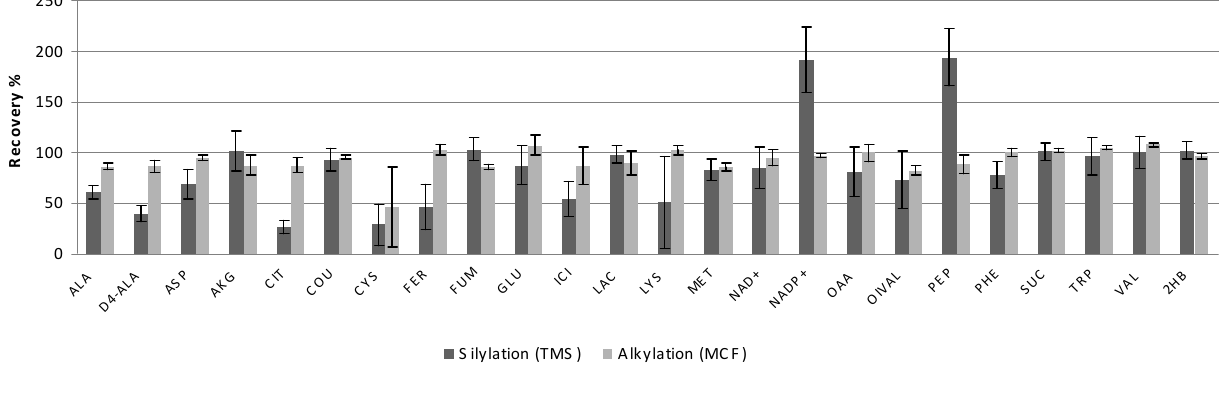
Figure 7. GC-MS chromatograms of derivatized extracellular metabolites from the same spent culture medium sample of Acidovorax temperans : A, sample derivatized by silylation reaction (TMS), and B, sample derivatized by alkylation reaction (MCF).